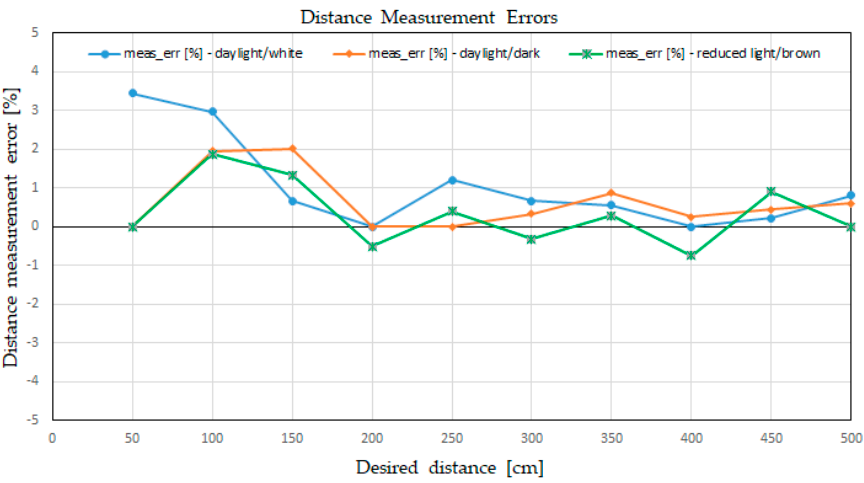
Figure 16. Plot of the distance measurement errors in various conditions.